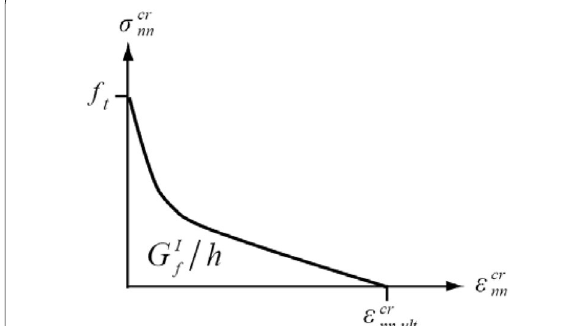
Fig. 18 Hordijk tension